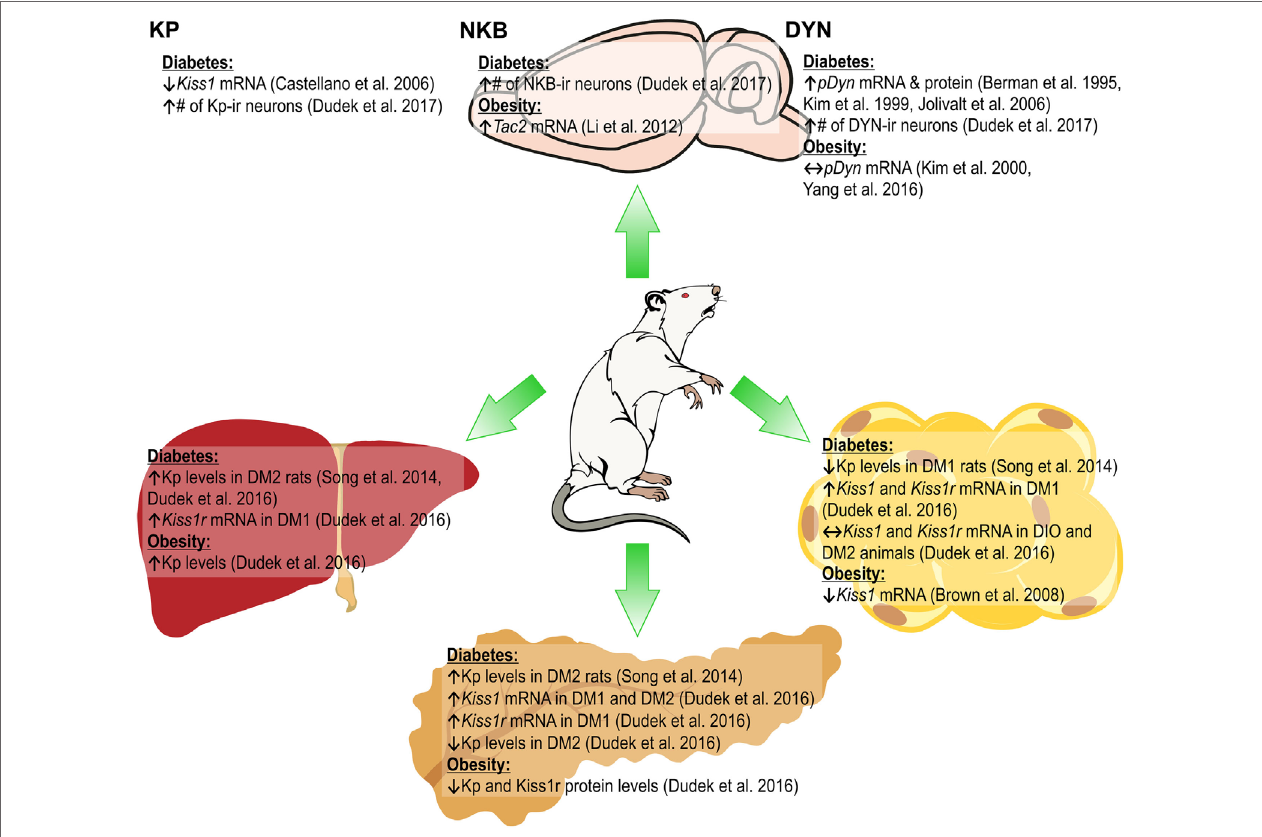
FigURe 1 | Changes in the expression of KNDy peptides [kisspeptin (Kp), neurokinin B (NKB), and dynorphin (DYN)] in the arcuate nucleus of the hypothalamus (ARC; upper part) and Kiss1/Kiss1r in peripheral organs (lower part) of rat due to diabetes obesity. ↑ , increase; ↓ , decrease; ↔ , no effect (11, 26, 28, 30, 33–36, 54,